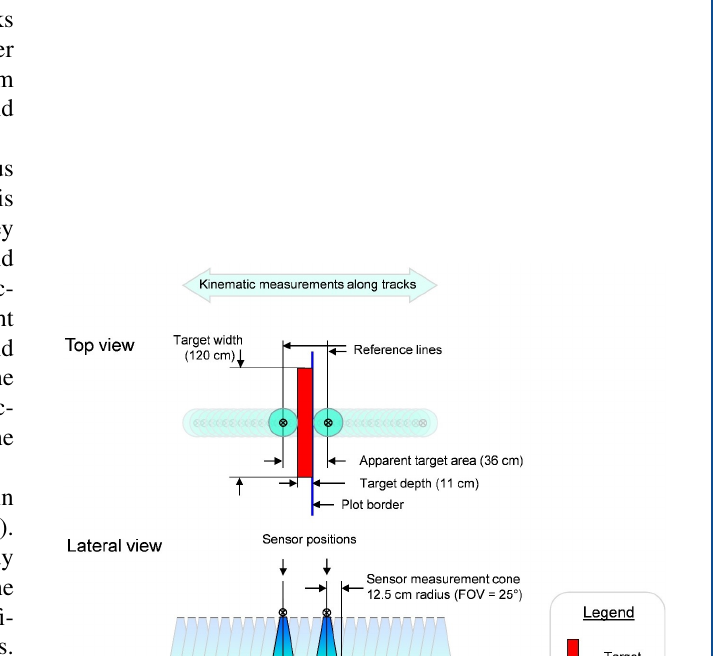
Figure B1. Display of reference targets (wooden planks) at the front ends of the study plot. Targets of defined dimensions and po- sitions allowed the passage of the sensor vehicle moving lane-by- lane.